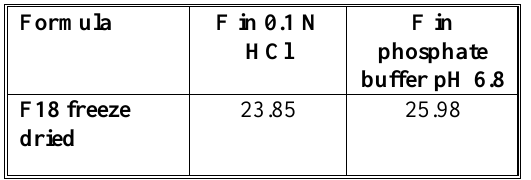
Table 5. Similarity factor f 2 for F18 freeze dried nanosuspension in two solvent ( 0.1N HCl and phosphate buffer pH 6.8 ) in comparison with